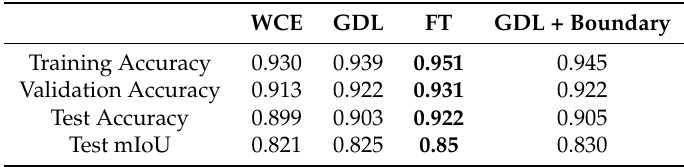
Table 3. Model performance varying the loss